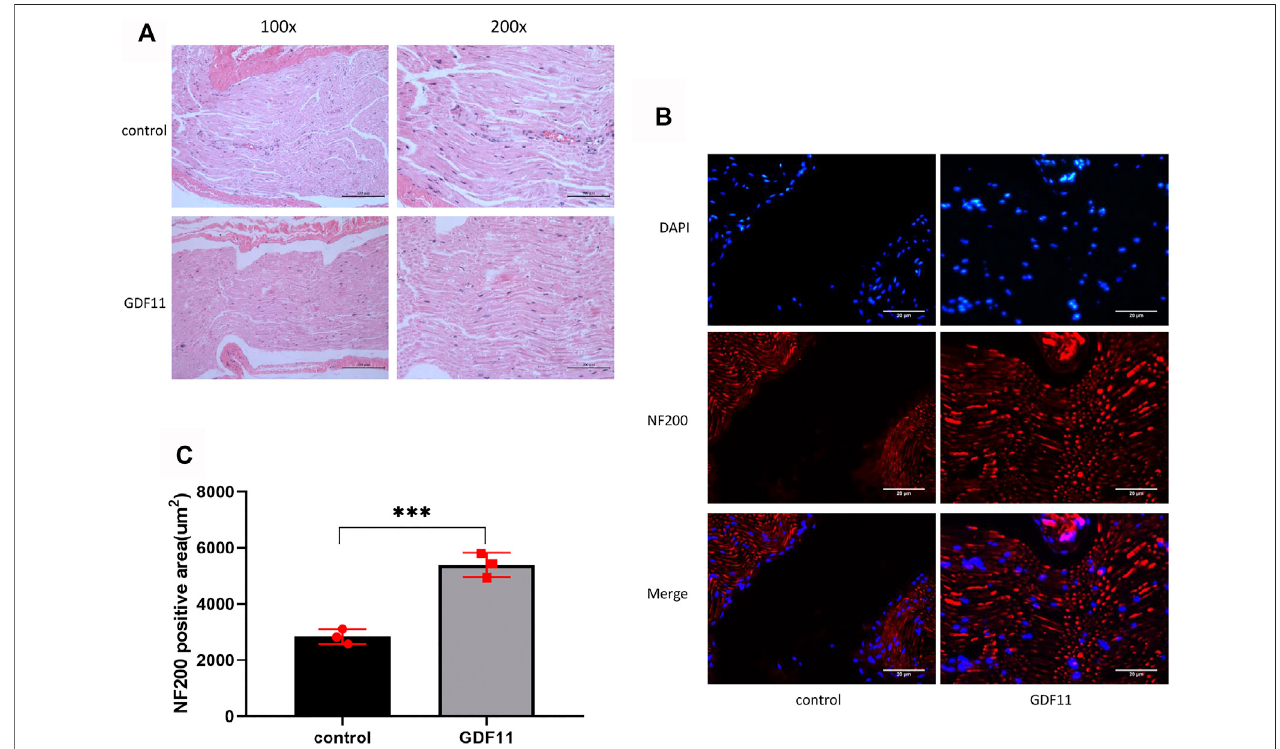
FIGURE 5 | GDF11 promotes regeneration of damaged sciatic nerve in rats. (A). HE staining was used to observe the recovery of rat sciatic nerve 3 months after operation( n (cid:1) 3). (BandC). Thenerve fi berswerelabeledwithNF200andthenervegrowthwasdetectedbyimmuno fl uorescence( n (cid:1) 3).Statisticalanalysiswasbased on at least three different biological samples and three technical replicates, p < 0.05 was considered to be statistically signiand fi lig;cant. Representative images are